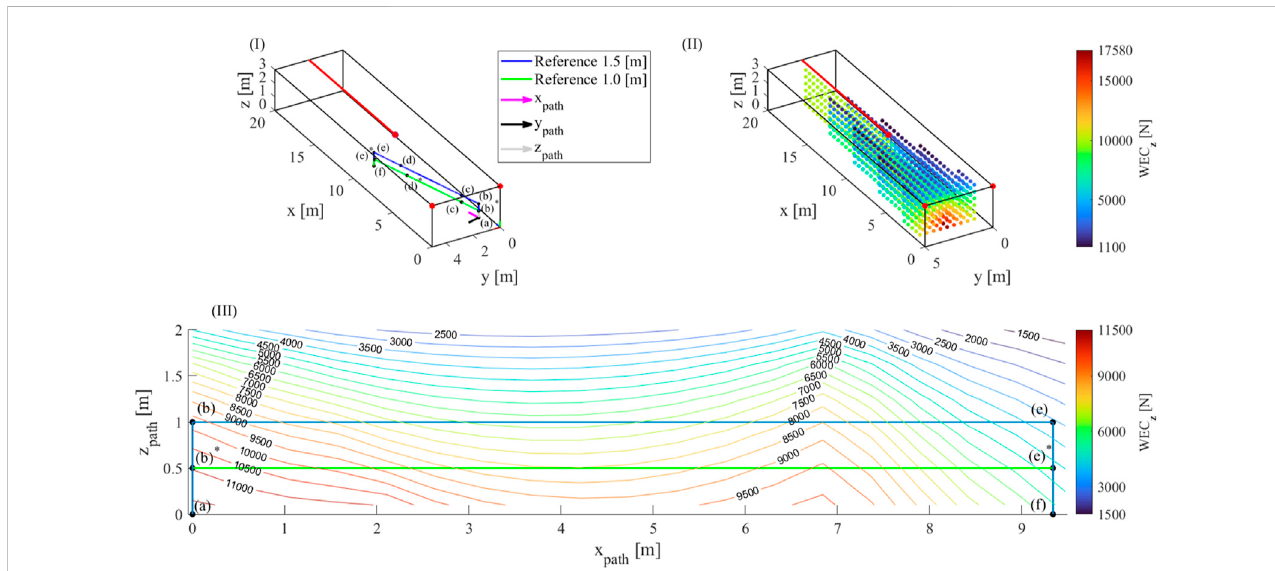
FIGURE 3 Representation of the considered paths (I), outcome of the WEC z workspace analysis (II) and comparison among the desired paths and WEC z values (III).